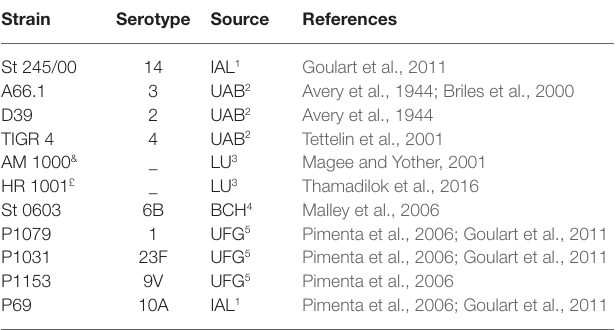
TABLE 1 | Streptococcus pneumoniae isolates